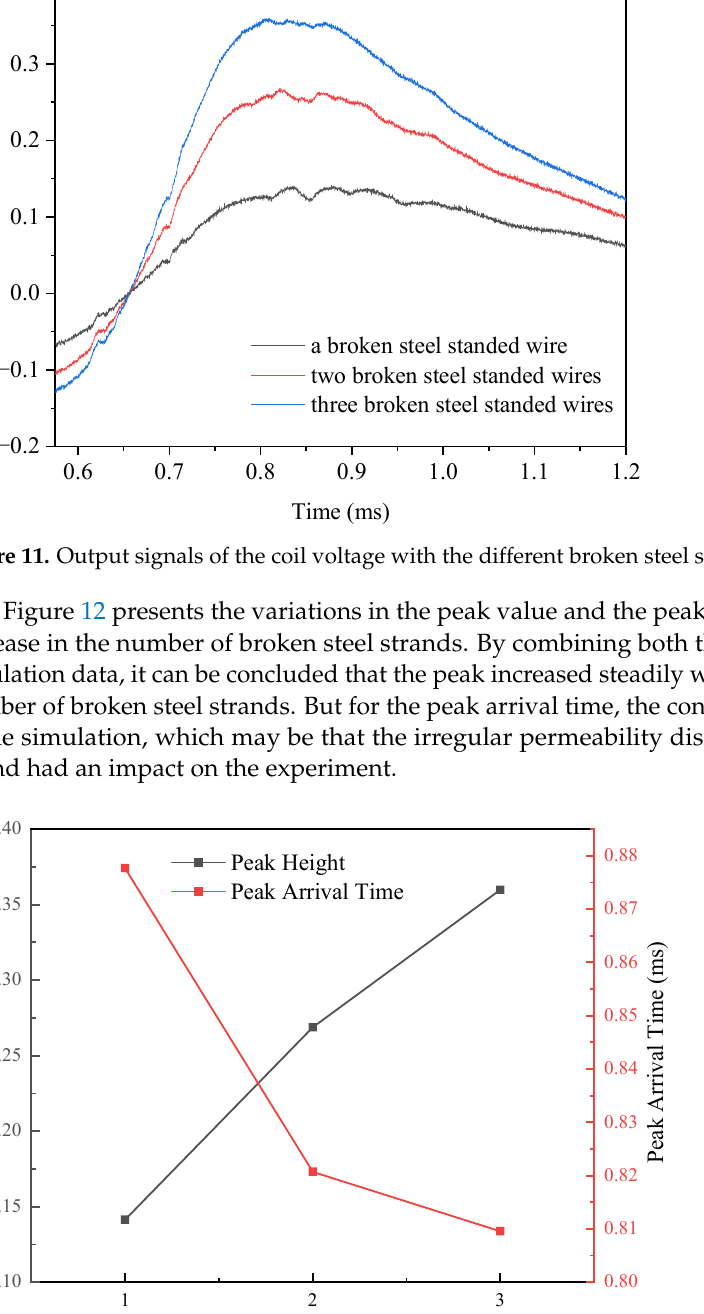
Figure 12. Relationship between the peak value, the peak arrival time, and the different broken steel strands.